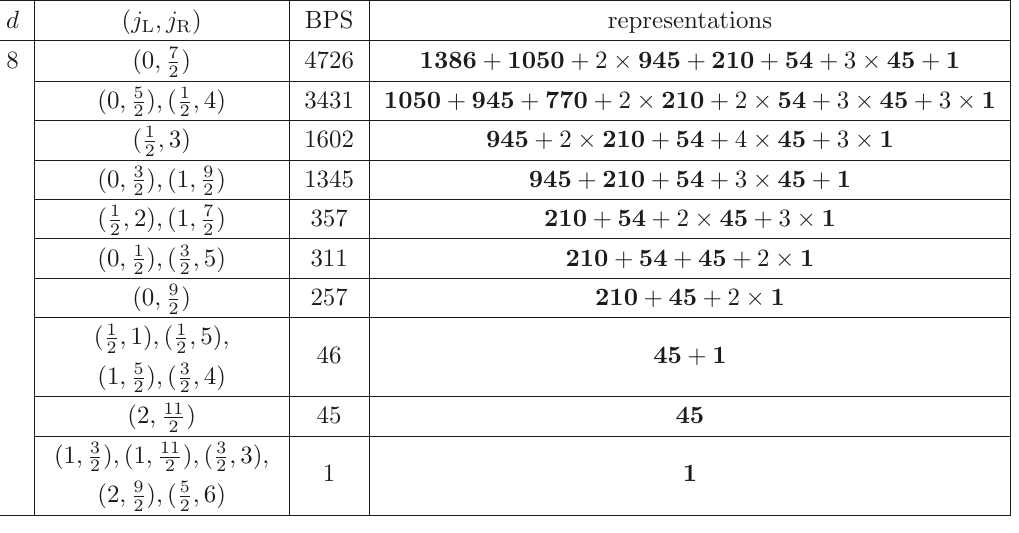
Table 3 . The constituent representations for the total BPS indices of the (2 , 2) model for d = 8. worldsheet instantons in appendix C.1.3 of [36] and the WKB expansion of the membrane instantons in (A.5). With both the data we can again fix exactly which representations appear in the total BPS indices. The results are listed in table